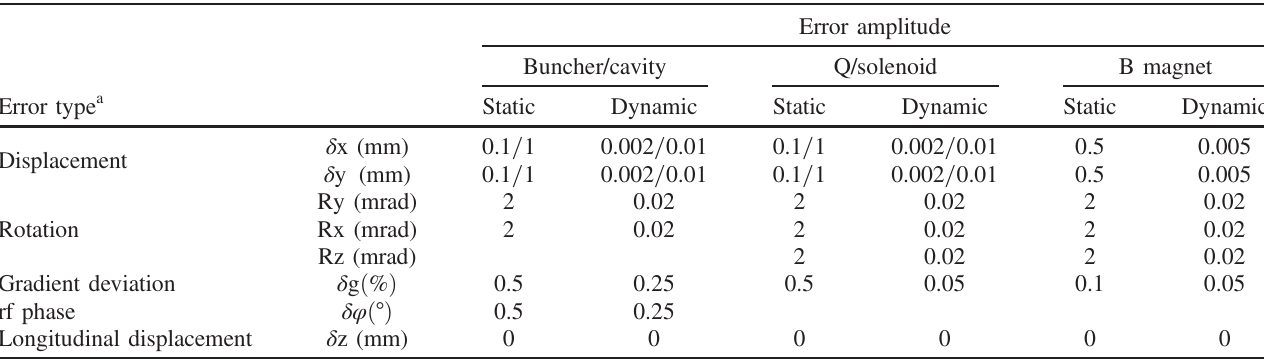
TABLE IV. The rf errors and misalignments amplitude for the injector error